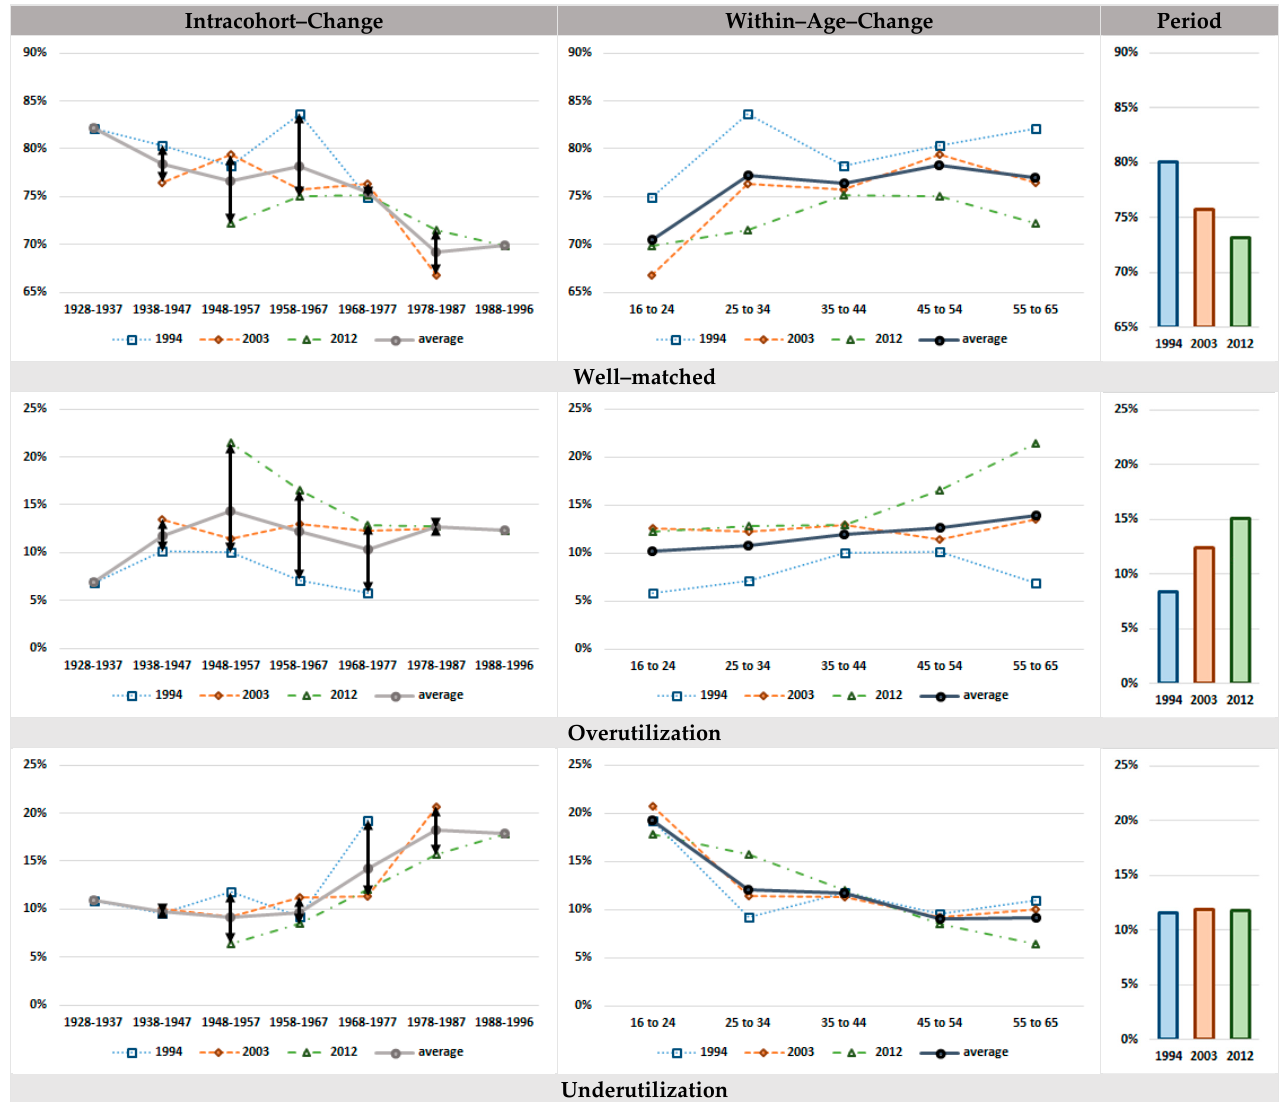
Figure 2. The incidence and change of literacy skill mismatch.